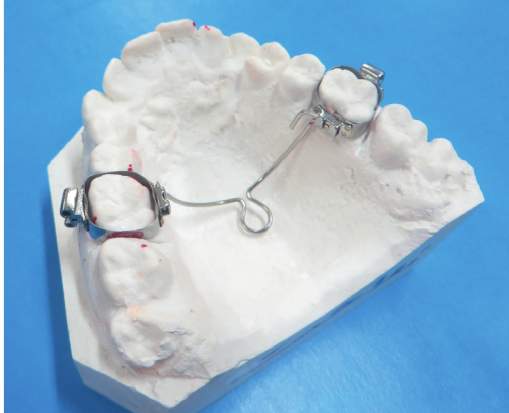
Figure 1: An inactive transpalatal arch.